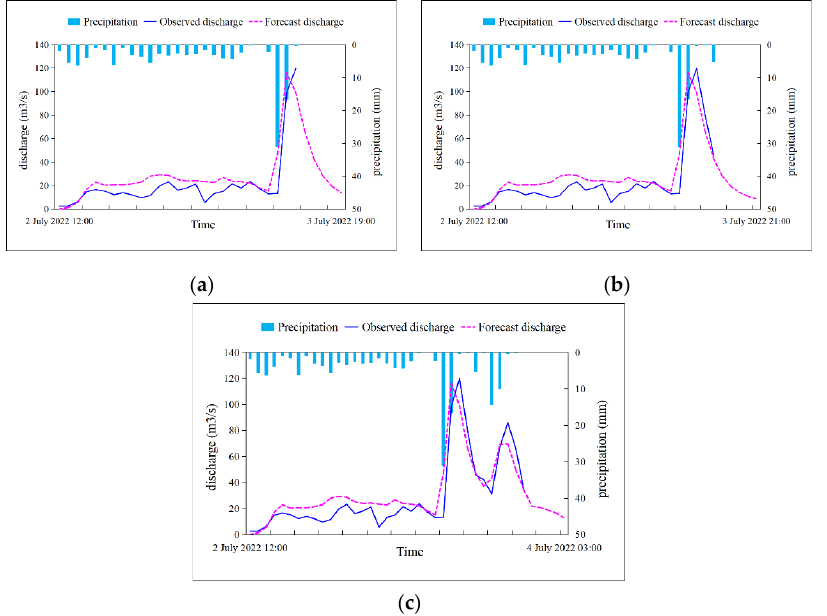
Figure 10. Three rounds of forecasts for the flood 2 July 2022. ( a ) First-round forecast results; ( b ) second-round rolling forecast results; and ( c ) third-round rolling forecast results.